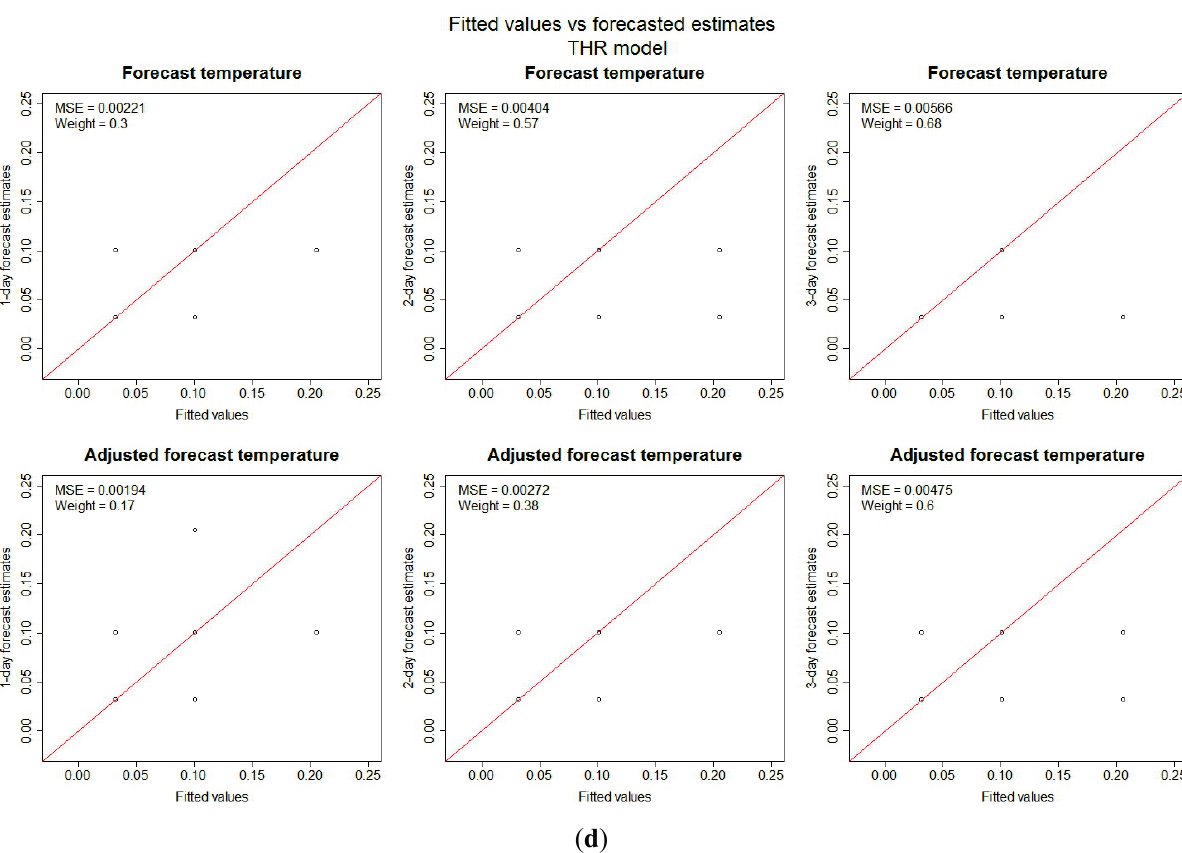
Figure 3. Risk estimates for the four models using fitted values from observed temperatures and the forecast temperatures on days with temperature above 26